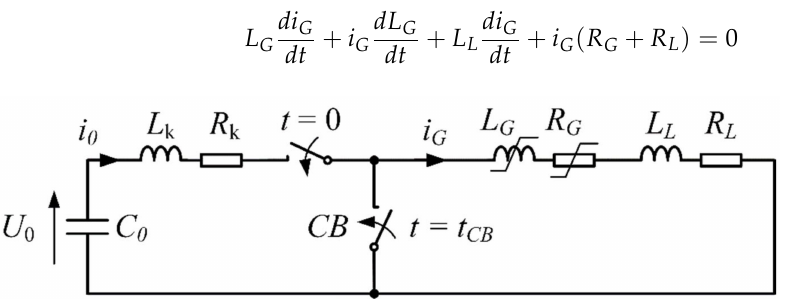
Figure 3. Substitute flux compression generator circuit diagram: i G —FCG current, t CB —time moment of the CB short, other markings in accordance with Figure